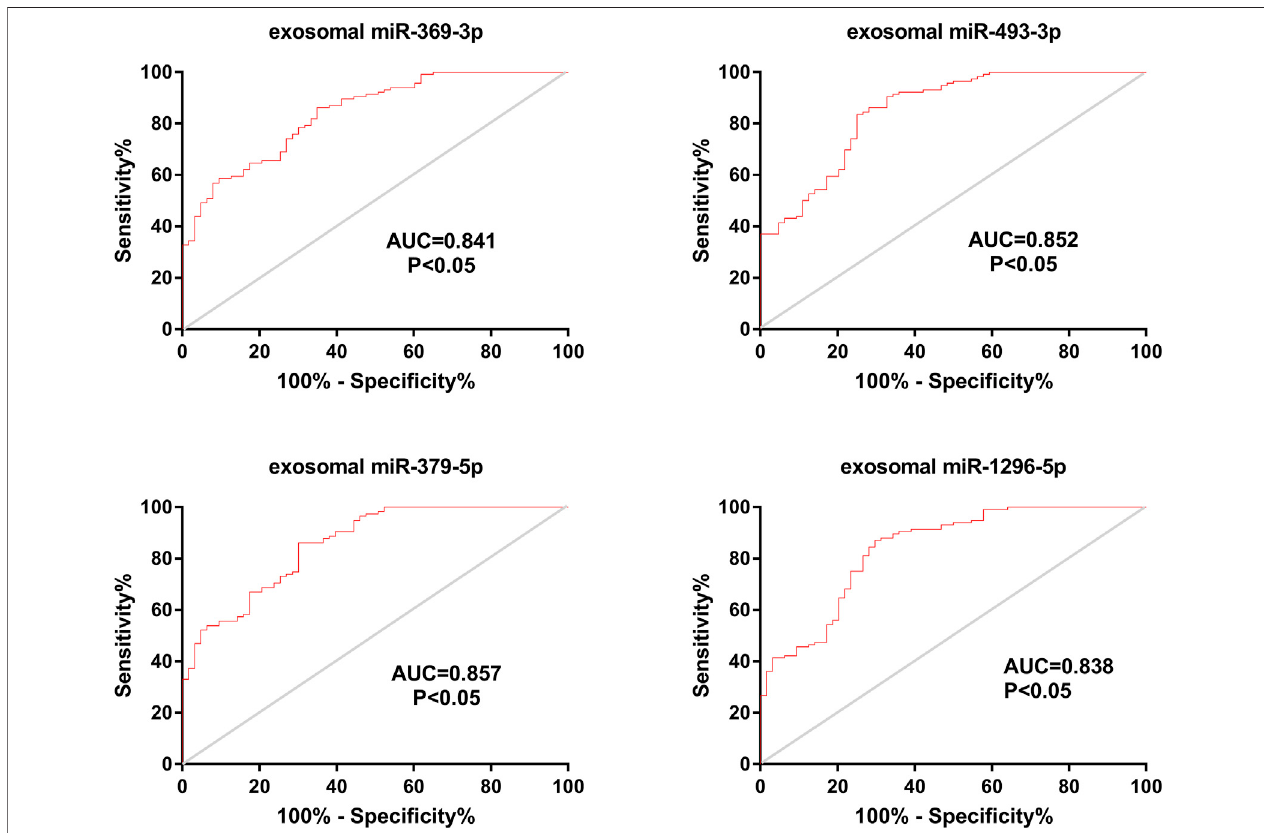
FIGURE 4 | Diagnostic ef fi ciency of exosomal miRNAs in the validation phase. ROC curve analyses were performed. The AUCs of the 4 exosomal miRNAs were calculated and are shown in red.